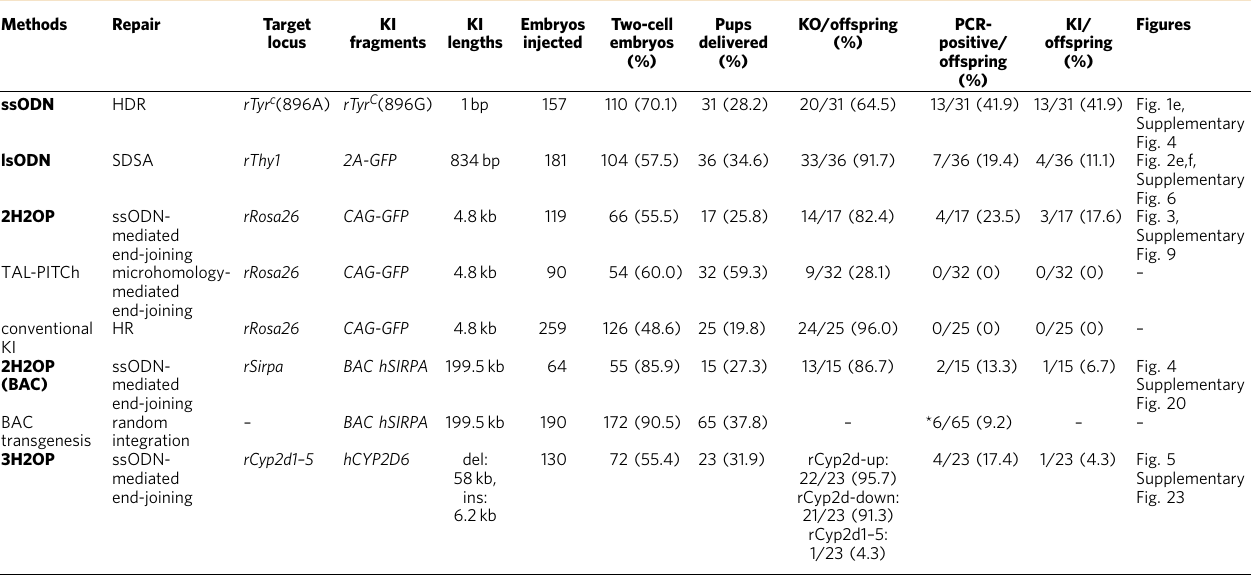
Table 1 | Comparison of methods for gene KI in rat zygotes.